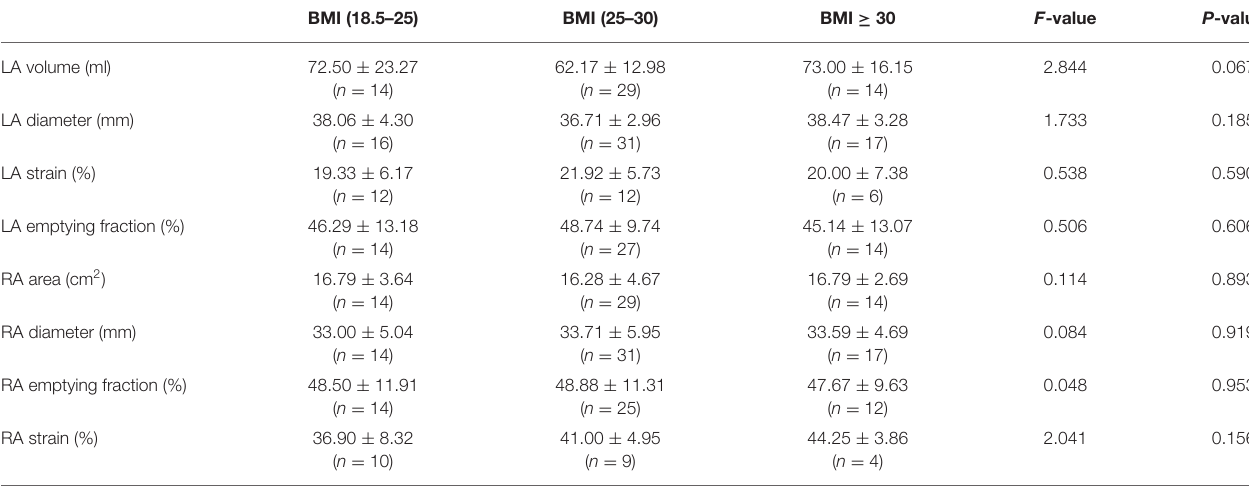
TABLE 2 | Comparisons of the atrial function measured by the echocardiography between the groups based on BMI.